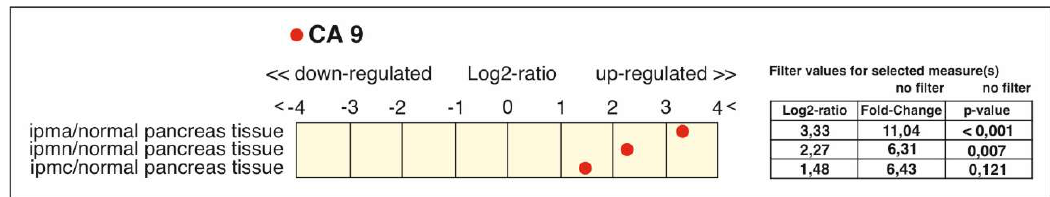
Figure 5. Upregulation of CA9 in intraductal papillary mucinous neoplasm (IPMN) samples compared to normal pancreatic tissue. The analysis was performed in Genevestigator (Nebion AG), a multi-organism microarray data analysis toolbox, using data from experiment No. HS-00705 (GSE19650) comprising 21 samples of intraductal papillary-mucinous adenoma (ipma, n = 6), adenocarcinoma (ipmc, n = 6), invasive carcinoma (ipmn, n = 3), and normal pancreatic duct tissue ( n = 6). The graph shows a log fold change between various types of mucinous neoplasia tissues and healthy tissue samples; p denotes significance of changes.